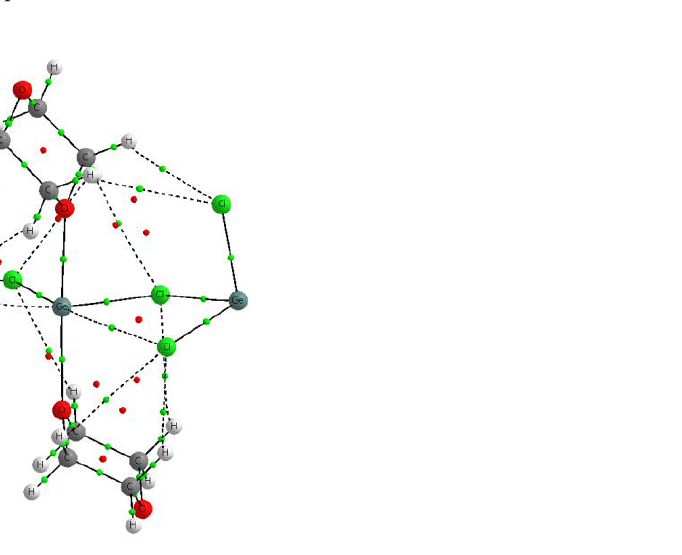
Figure 6. The molecular graphs of ( a ) GeBr 2 -C 4 H 8 O 2 and ( b ) GeBr 2 -(C 4 H 8 O 2 ) 2 ; big circles correspond to the attractors (red — oxygen, brown — bromine, grey — germanium, white — hydrogen), small green circles to the bond critical points and red circles to the ring critical points; solid and broken lines indicate bond paths.